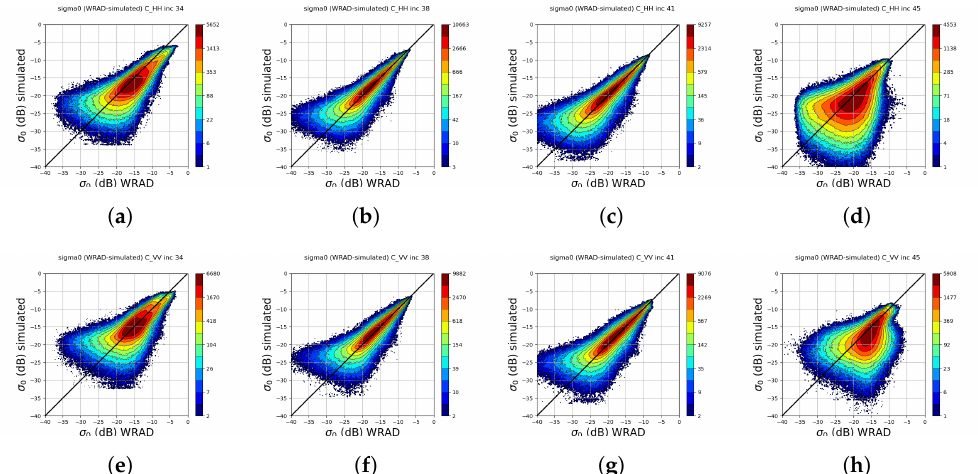
Figure 6. Joint distribution of C-band measured σ ° and simulated σ °, ascending orbits, date 1 March 2022–9 March 2022, HH (upper panel), VV (lower panel): ( a , e ) incidence angle 34°; ( b , f ) incidence angle 38°; ( c , g ) incidence angle 41°; ( d , h ) incidence angle